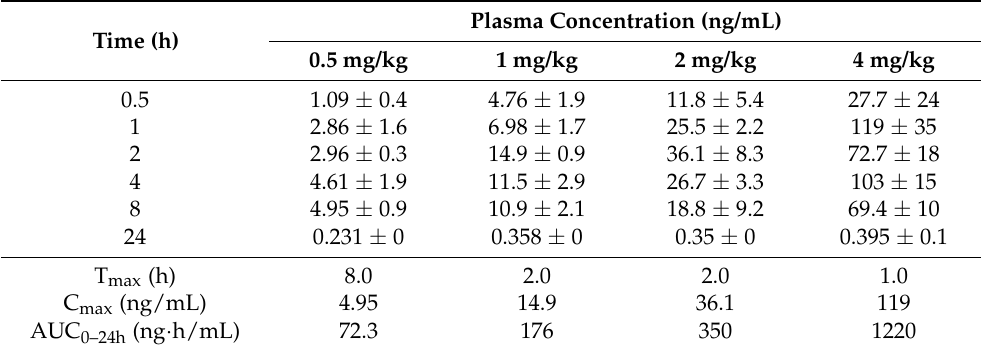
The data are expressed as the mean ± SD ( n =